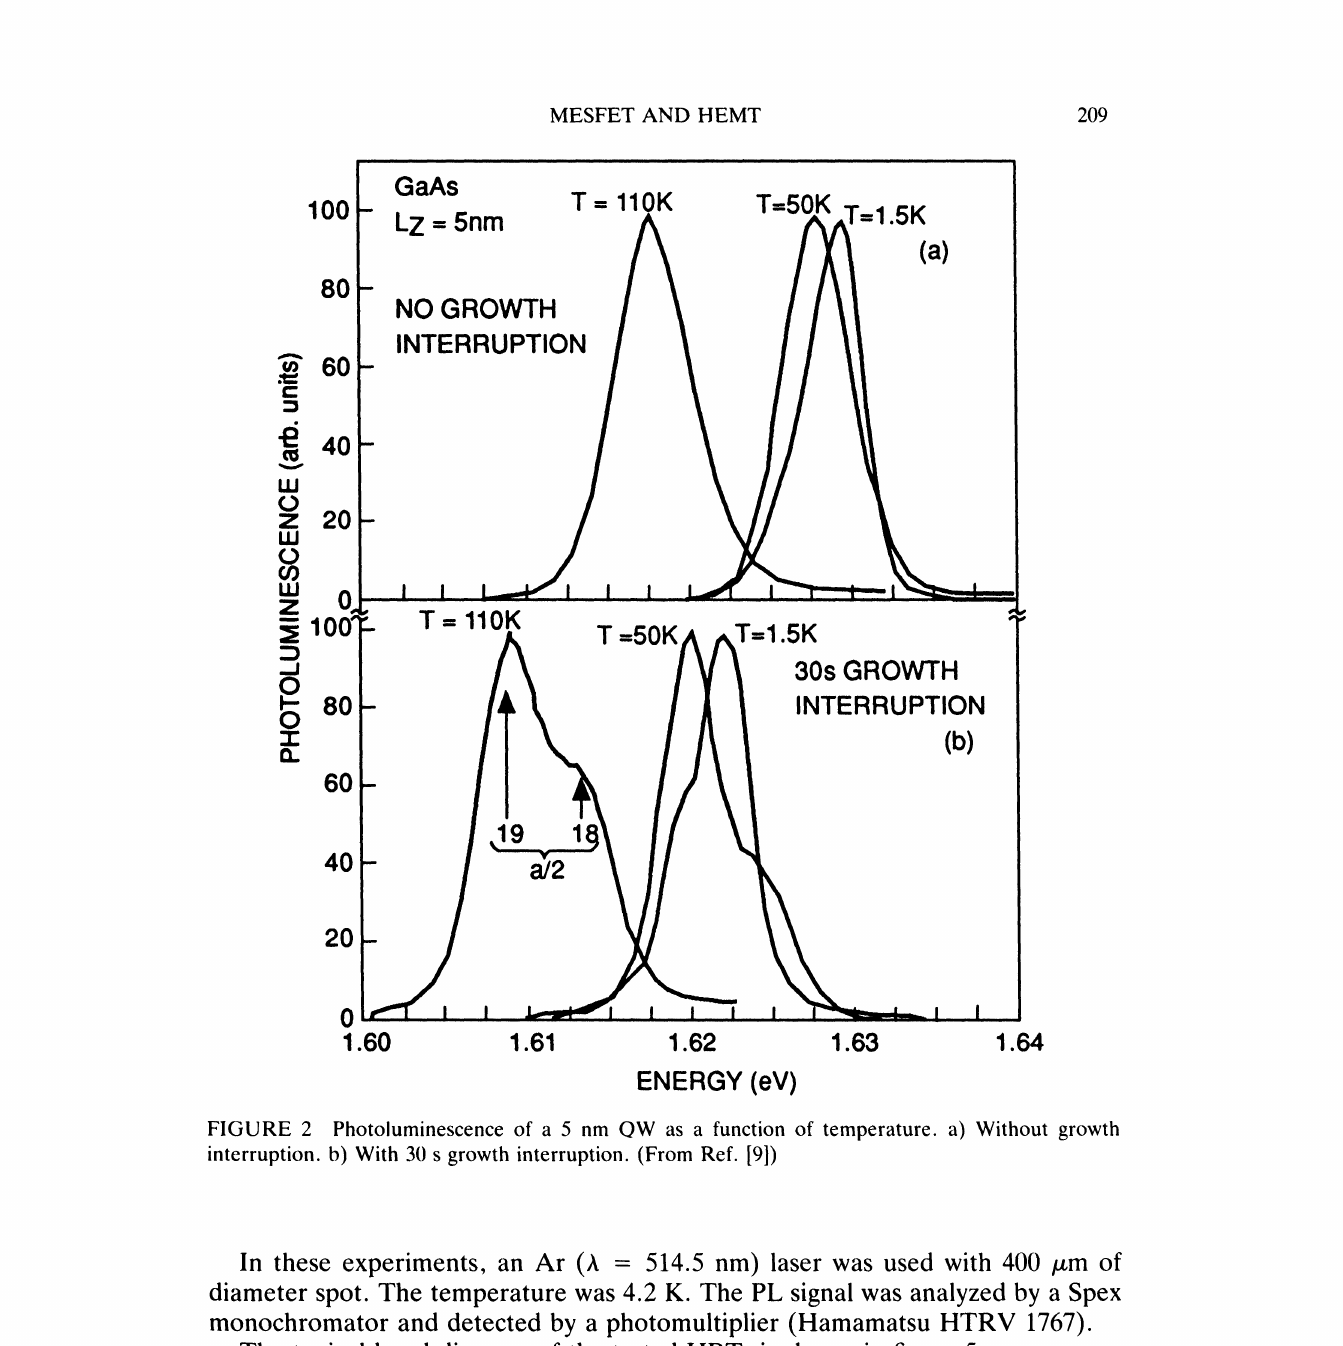
FIGURE 2 Photoluminescence of a 5 nm QW as a function of temperature, a) Without growth interruption, b) With 30 growth interruption. (From Ref.